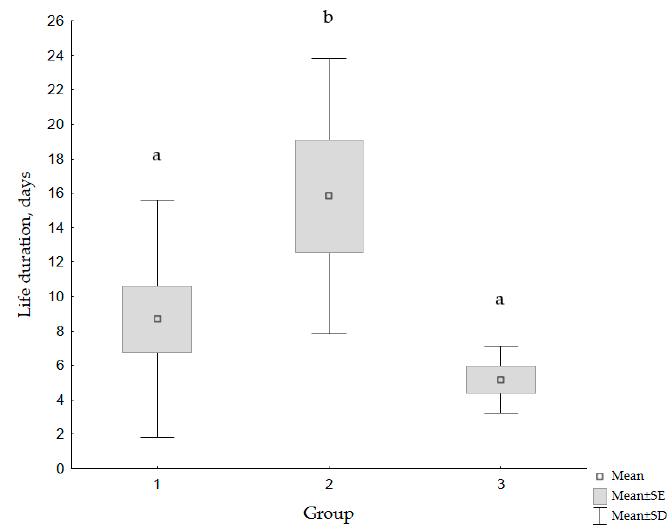
Figure 5. Life duration after C max exposure of crayfish three experimental groups: Group one got C max on day 4 ± 2; Group two on day 13 ± 1; and Group three was exposed to C max on day 38 ± 6. Life duration was: 9 ± 7 days, 16 ± 8 days, and 5 ± 2 days, respectively. There was a significant difference ( p < 0.05) in life duration between groups: Individuals from Group two in general lived more than twice as long as crayfish from Groups one and three after exposure to C max .